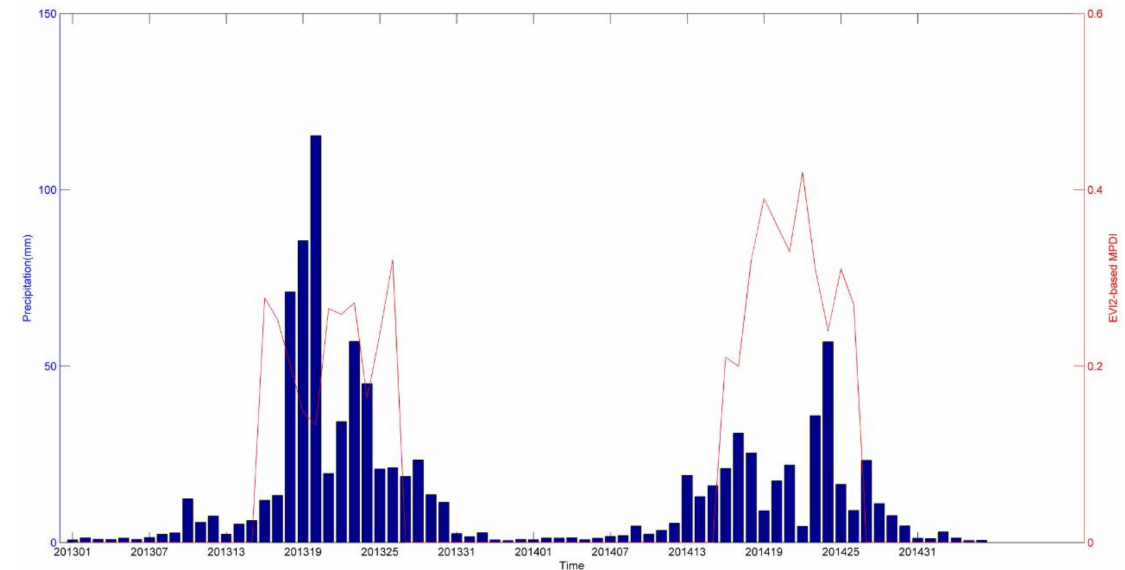
Figure 7. Temporal distribution of EVI2-based MPDI and precipitation during 2013 to 2014 at the Jinzhou meteorological